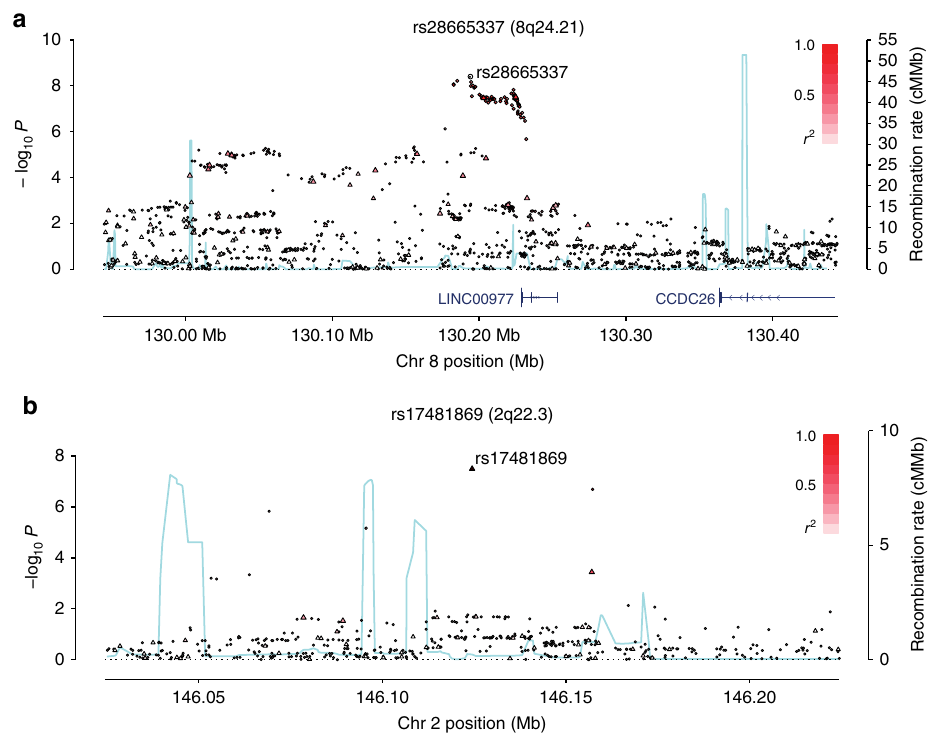
Fig. 2 Regional plots of association results and recombination rates for the identi fi ed risk loci. a 8q24.21 (rs28665337), b 2q22.3 (rs17481869). Plots (generated using visPIG 14 ) show association − log 10 P- values (left y -axis) of genotyped (triangles) and imputed (circles) SNPs in the GWAS samples (2442 cases and 14,609 controls) and recombination rates (right y- axis). − log 10 P -values were calculated assuming an additive model in SNPTEST v2.5.2 and are shown according to their chromosomal positions ( x -axis). Lead SNPs are denoted by large circles or triangles labeled by rsID. Color intensity of each symbol re fl ects LD, white ( r 2 = 0), dark red ( r 2 = 1.0). Light blue line shows recombination rates from UK10K Genomes Project. Genome coordinates